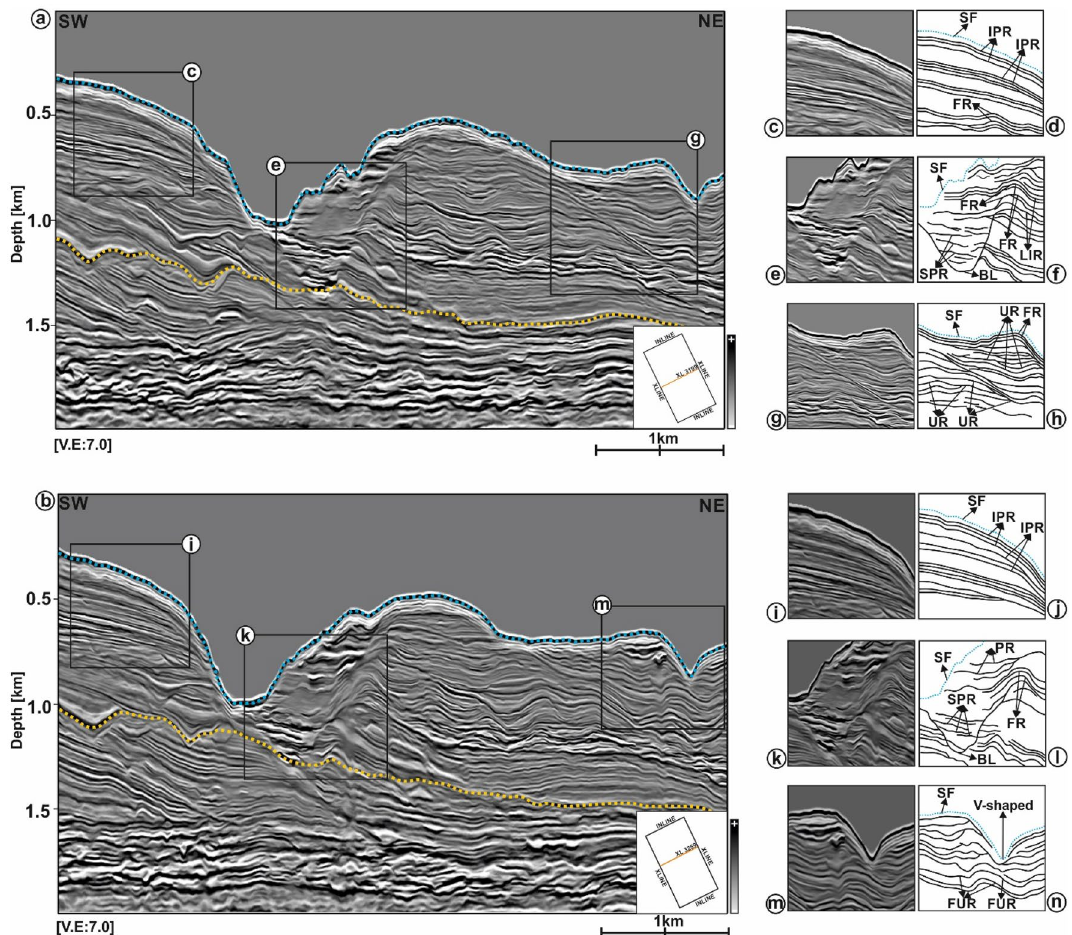
Figure 7. Seismic reflection character of the Waitaki Submarine Canyon as observed in lines ( a ) XL 3199 and ( b ) XL 3259 in the SW, central and NE parts of the study area. The seismic characters ( c – g,i – m ) are interpreted Folded Reflections, SPR Stacked Parallel Reflections, LIR Laterally Inclined Reflections, FUR Folded Upward Reflections, UR Undulated Reflections, PR Parallel Reflections, BL Basal